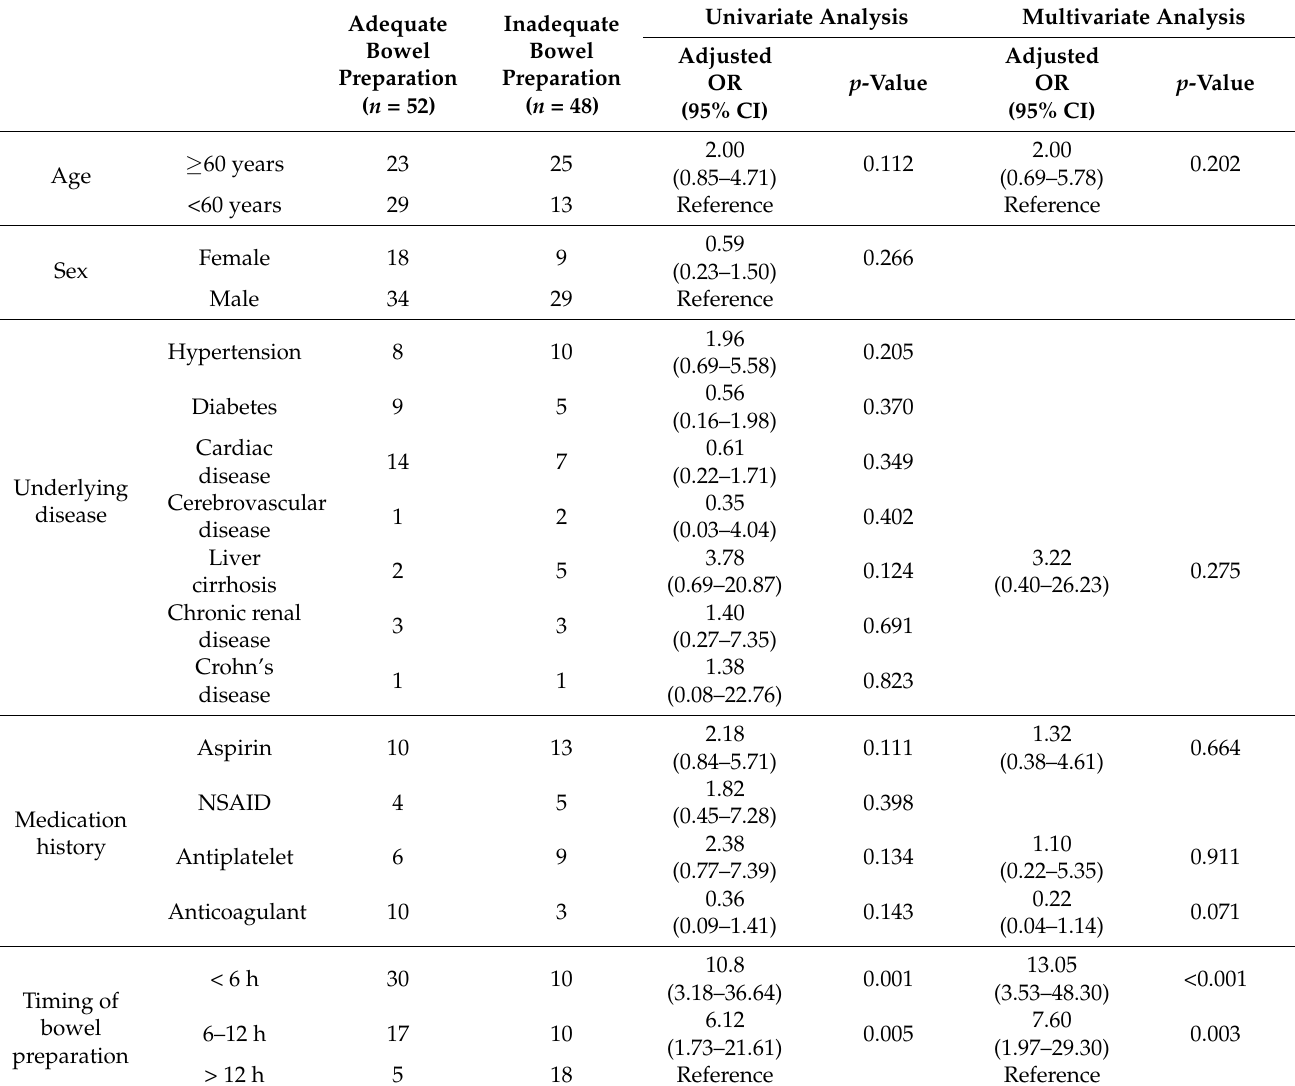
Table 6. Univariate and multivariate logistic regression analyses of factors affecting small bowel visibility quality